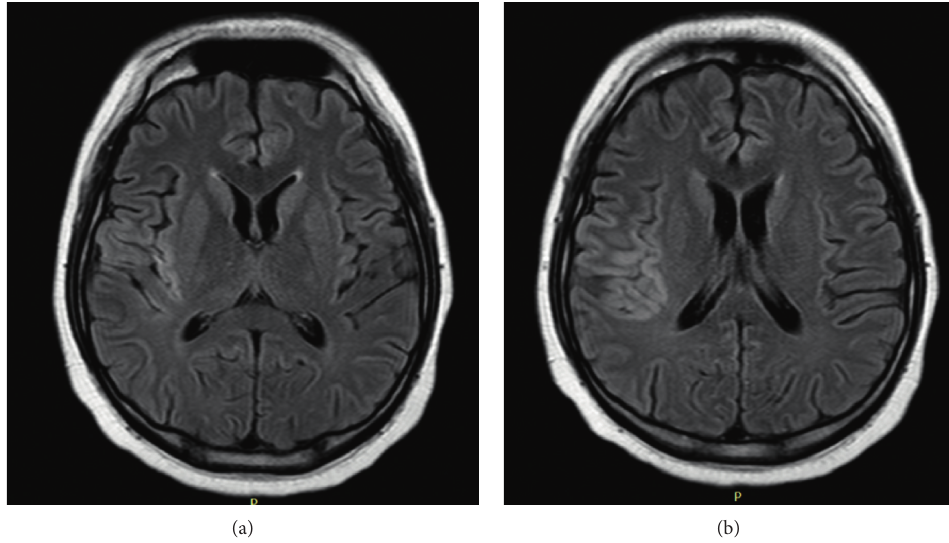
Figure 3: FLAIR: hyperintensity over right temporal lobe and insular region.